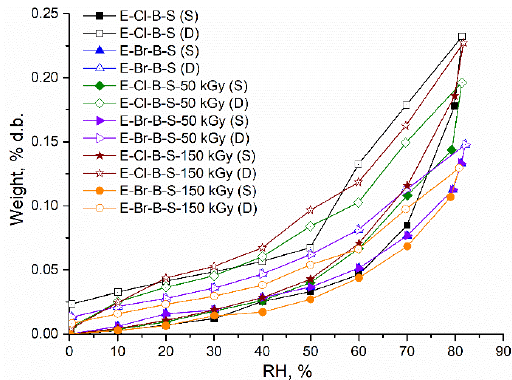
Figure 14. Dynamic vapor sorption isotherms for tested composites E-S; E-B-S.